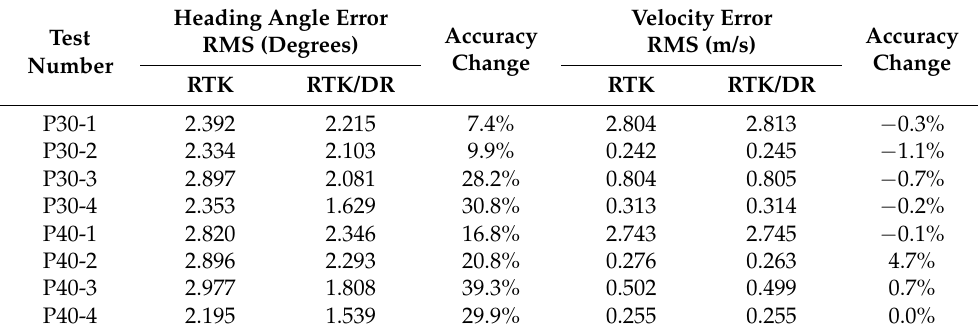
Figure 10. RTK/DR positioning track. ( a ) Smartphone Huawei P30; ( b ) Smartphone Huawei P40. In order to further compare the RTK/DR positioning performance to RTK, this work determines the direction error and velocity error of the two smartphones in four in-vehicle navigation tests, as shown in Table 2. Table 2. Statistics of heading angle and velocity error achieved by using RTK/DR positioning method.